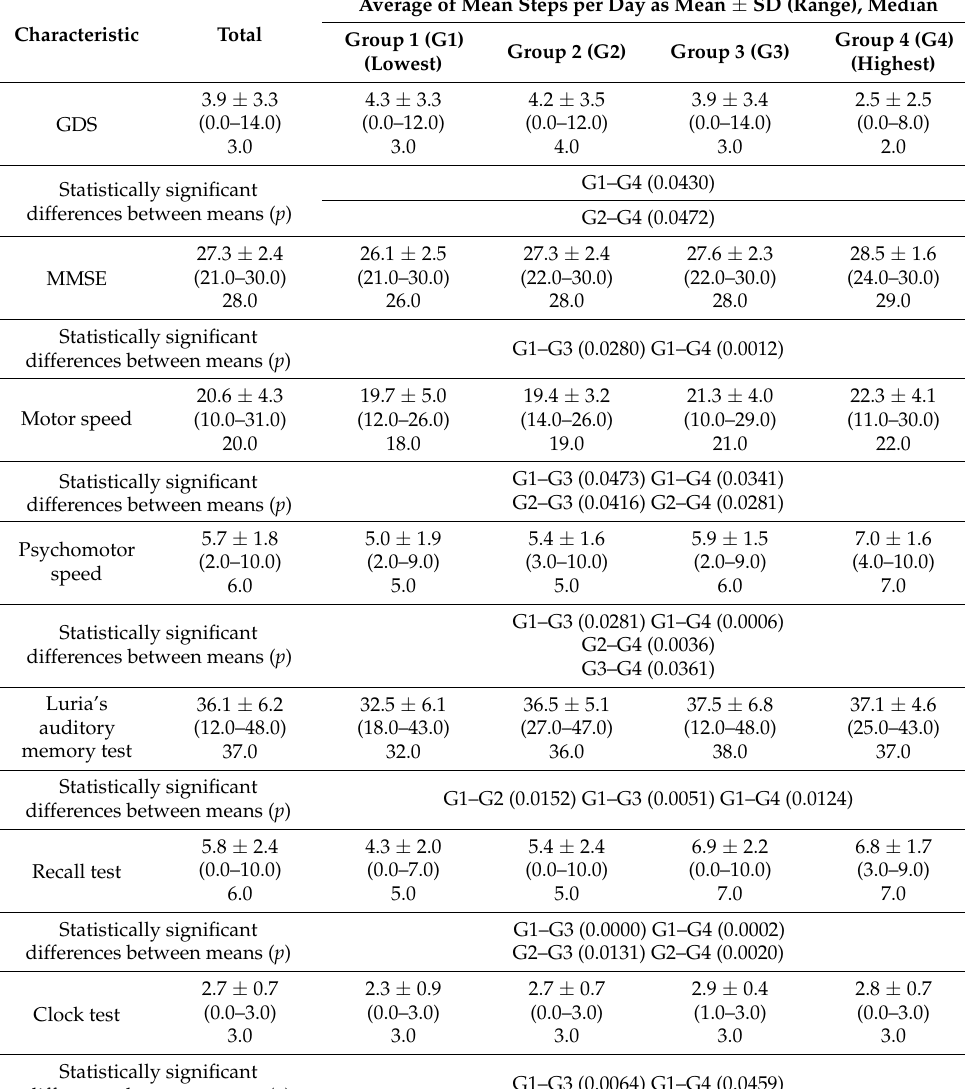
Table 2. Characteristics of the cognitive function